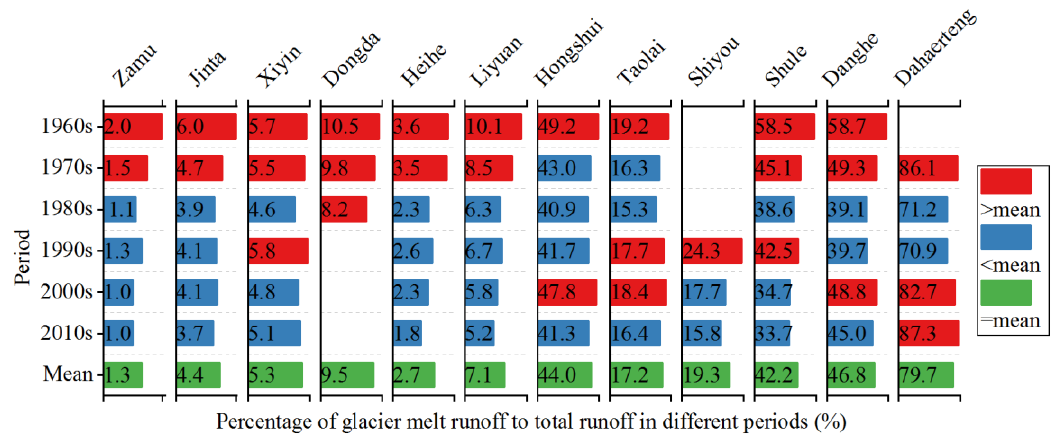
Figure 8. The contribution of glacier melt runoff in each subbasin at different periods. Note: The bar plot and numbers in each column indicate the ratio changes of each subbasin during 1965–2016. The red bar indicates that the ratio in the corresponding period is larger than the mean ratio (green bar) at all times; additionally, the blue bar means that the ratio is smaller than the mean value. The total runoff of the Dongda River was missed after the 1990s, and the hydrological station of the Shiyou River was first measured in the 1990s. This situation is showed as blank in the Figure.